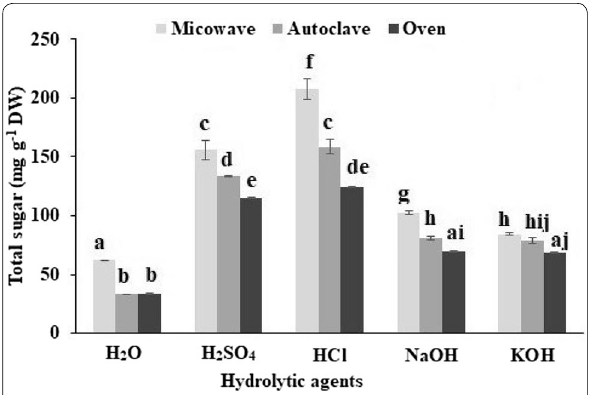
Fig. 7 Total sugar content in Scenedesmus sp. using a microwave, b autoclave and c oven pretreatments. The means and standard deviations of the three replicates are indicated. (P < 0.05 for different